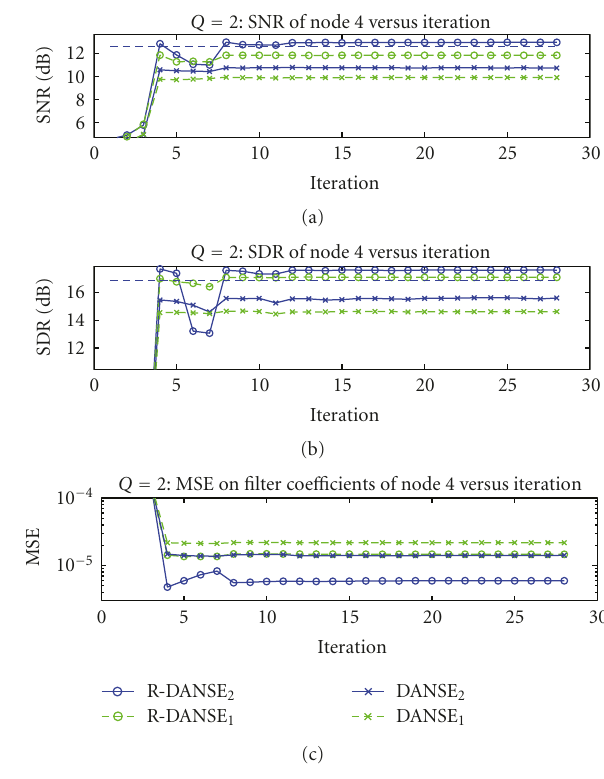
Figure 6: Scenario 1: SNR, SDR, and MSE on filter coe ffi cients versus iterations for DANSE 1 and R-DANSE 1 at node 4, for both sequential and simultaneous updates. Speaker C is the only target speaker.